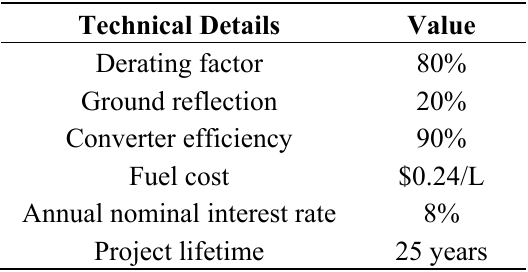
Table 2. Technical details of the